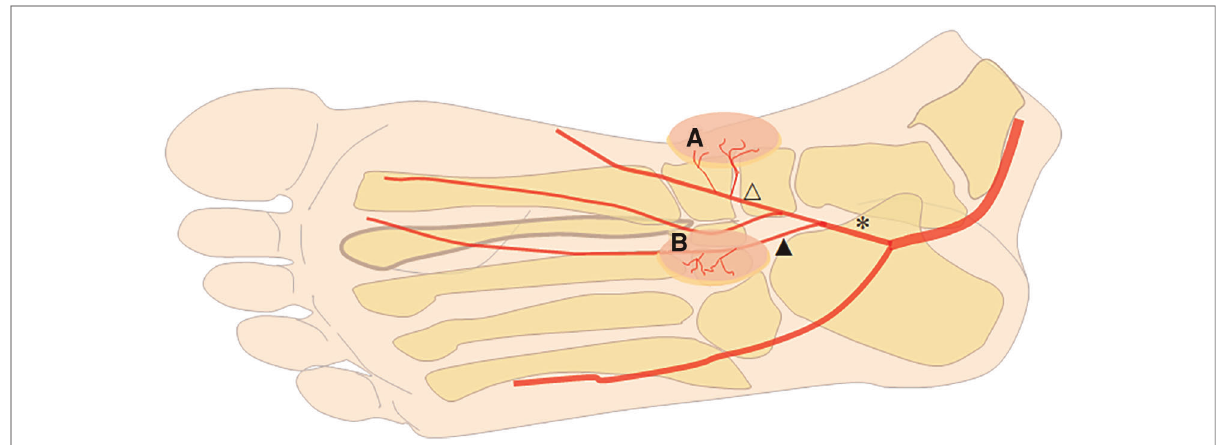
FIGURE 1 Schematic diagram of blood fl ow to the medial plantar artery perforator (MPAP) fl ap. A lobulated MPAP fl ap ( A and B ) originates from the medial branch of the deep branch of the MPA (blank triangle) and the super fi cial branch of the MPA (black triangle). Star: the medial plantar artery